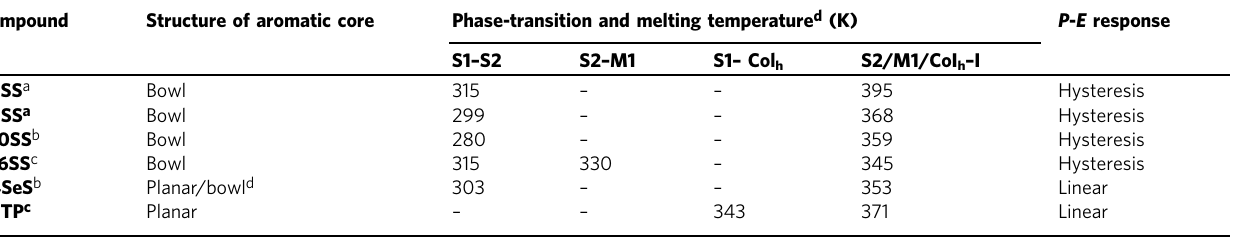
Table 1 Summary of structural features, thermal properties, and P – E hysteresis of C n SS, C n SeS, and C6TP. Compound